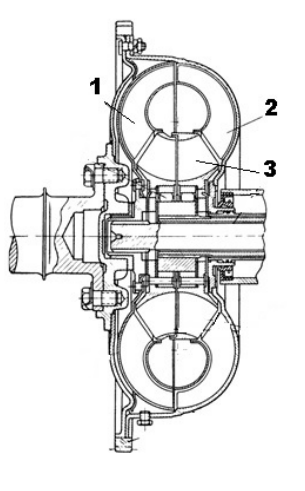
Figure 1 – Scheme of one HDTC Рис . 1 – Схема одного ГДТКМ Слика 1 – Шема једног ХДТОМ -